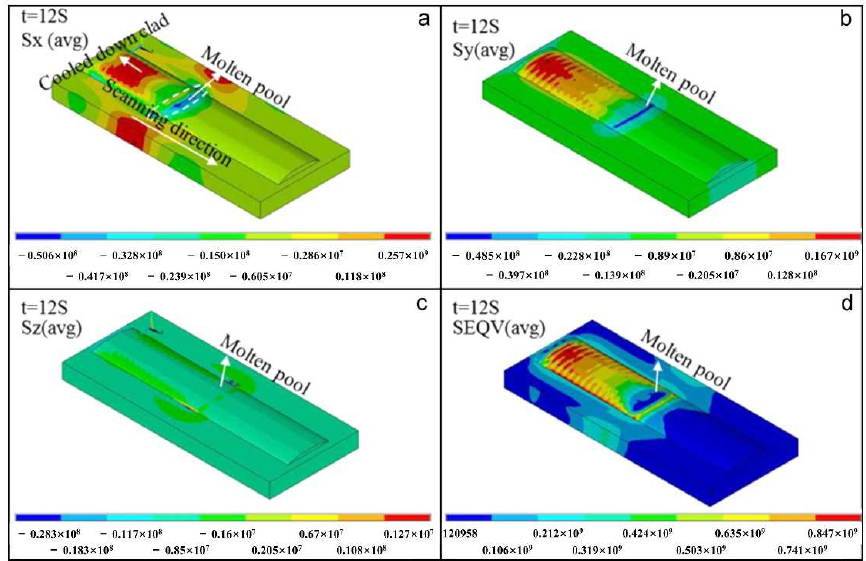
Figure 14. 3D-modeled contours of stress components in single-track laser cladding: ( a ) longitudinal stress SX; ( b ) transverse stress SY; ( c ) along-thickness stress SZ; ( d ) Von Mises equivalent stress SEQV [4].